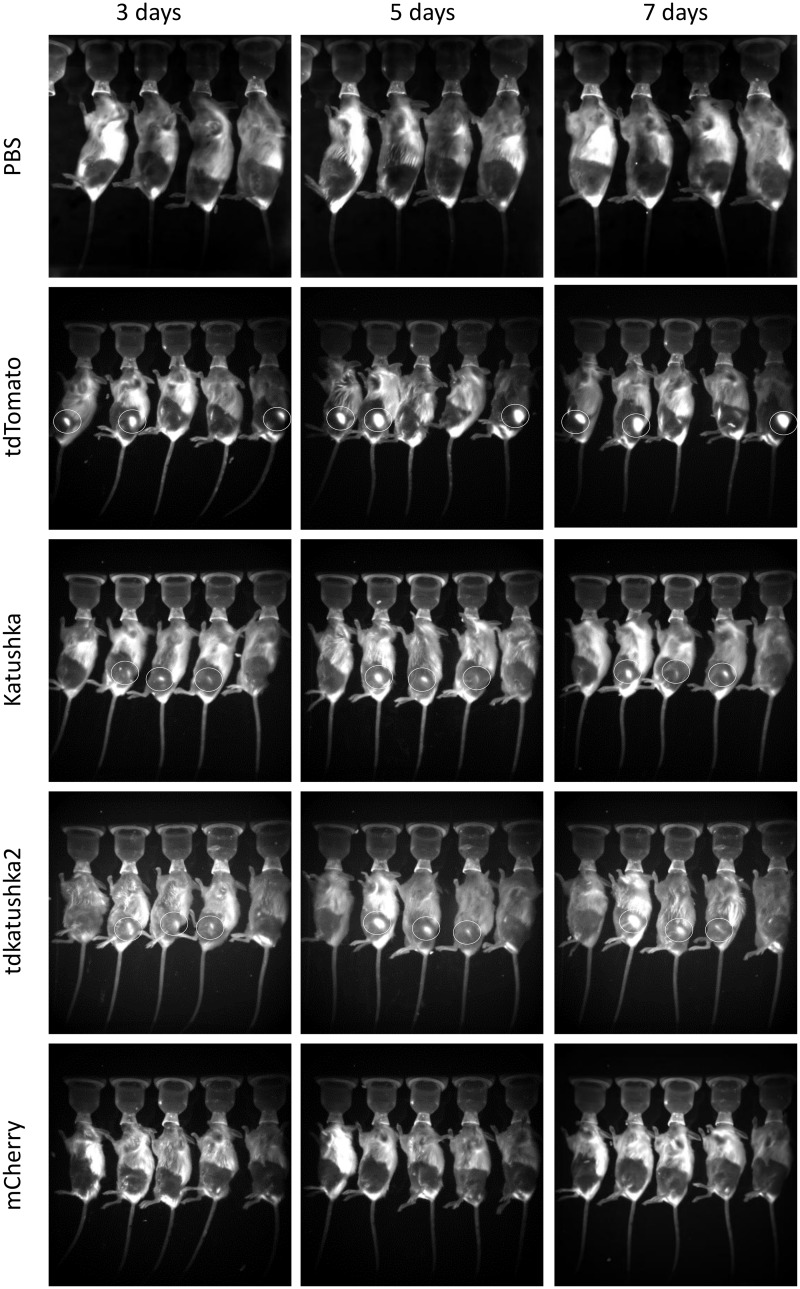
Comparison of red fluorescent proteins after intramuscular DNA delivery.Mice were injected i.m. with 50μg DNA in the anterior tibialis muscle and the site electroporated. At days 3, 5 and 7 after transfection, mice were imaged in vivo using an Imaging System at 550nm excitation and 600nm emission. Representative of n = 3 experiments. White circles indicate fluorescent protein expression.